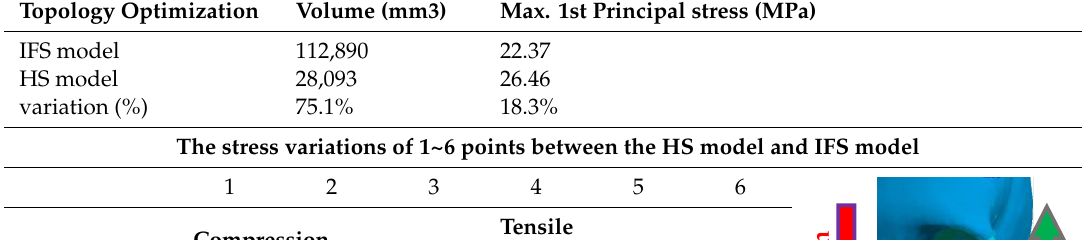
Figure 6. The stress distribution of the IFS model and HS model, ( a ) and ( b ) stress distributions of the IFS and HS models, respectively. High stress regions represented a similar trend as buttress pillars of the nasomaxillary and the zygomaticomaxillary buttresses. Table 1. The variation of maximum bone stress (maximum principal stress) and solid volume between the IFS and HS models.